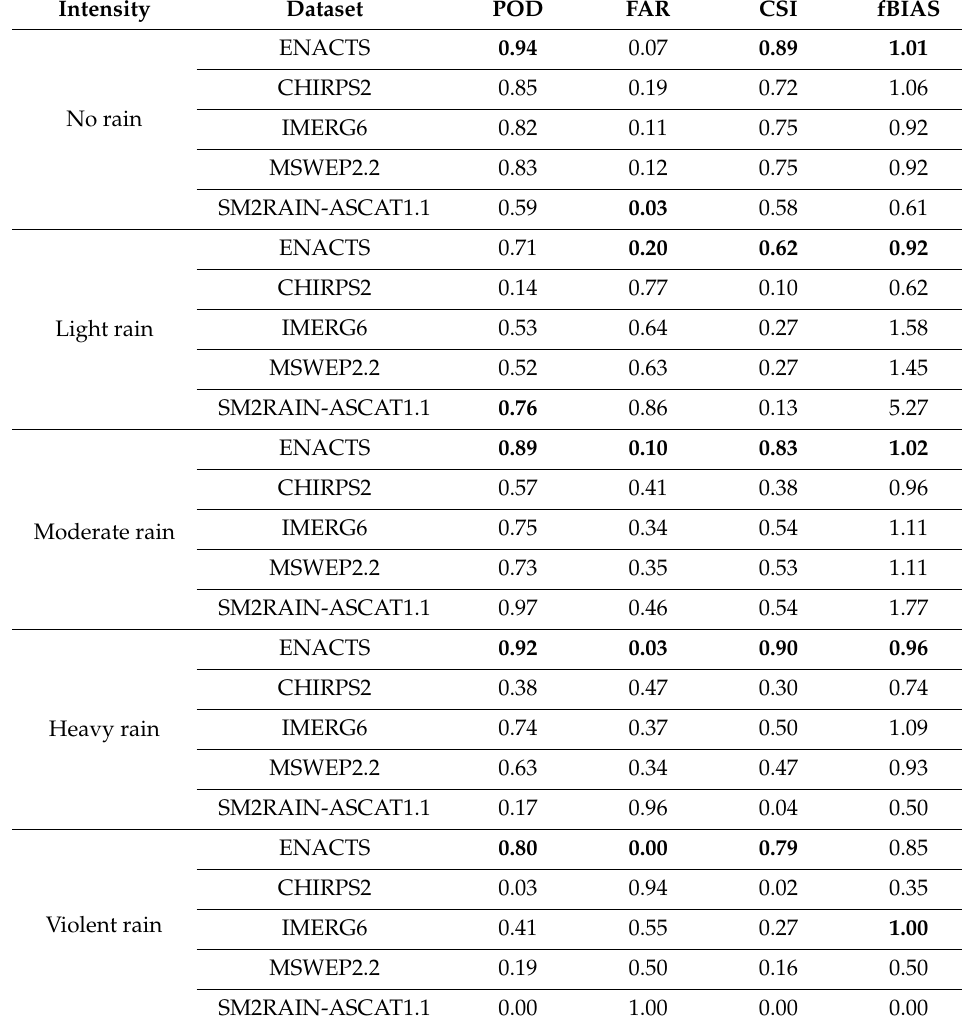
Table 3. Median values of categorical indices grouped for di ff erent daily precipitation intensity levels of UBNRB. Values in bold show the best score of each dataset in each intensity range. Intensity Dataset POD FAR CSI fBIAS ENACTS No rain